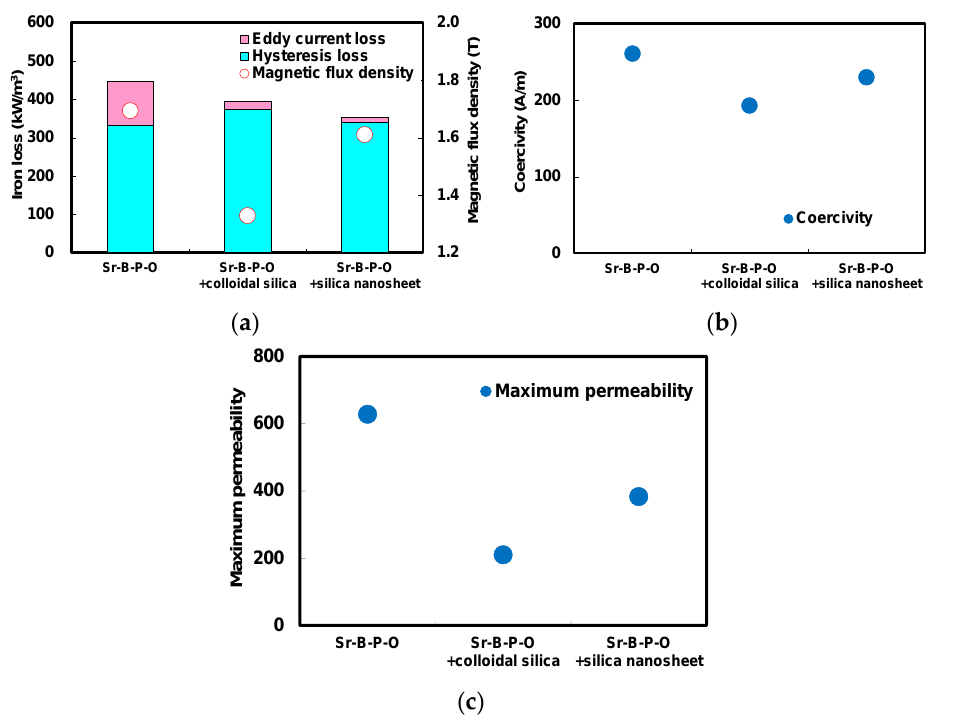
Figure 7. ( a ) Iron losses, magnetic flux densities; ( b ) coercivities; and ( c ) maximum permeabilities of